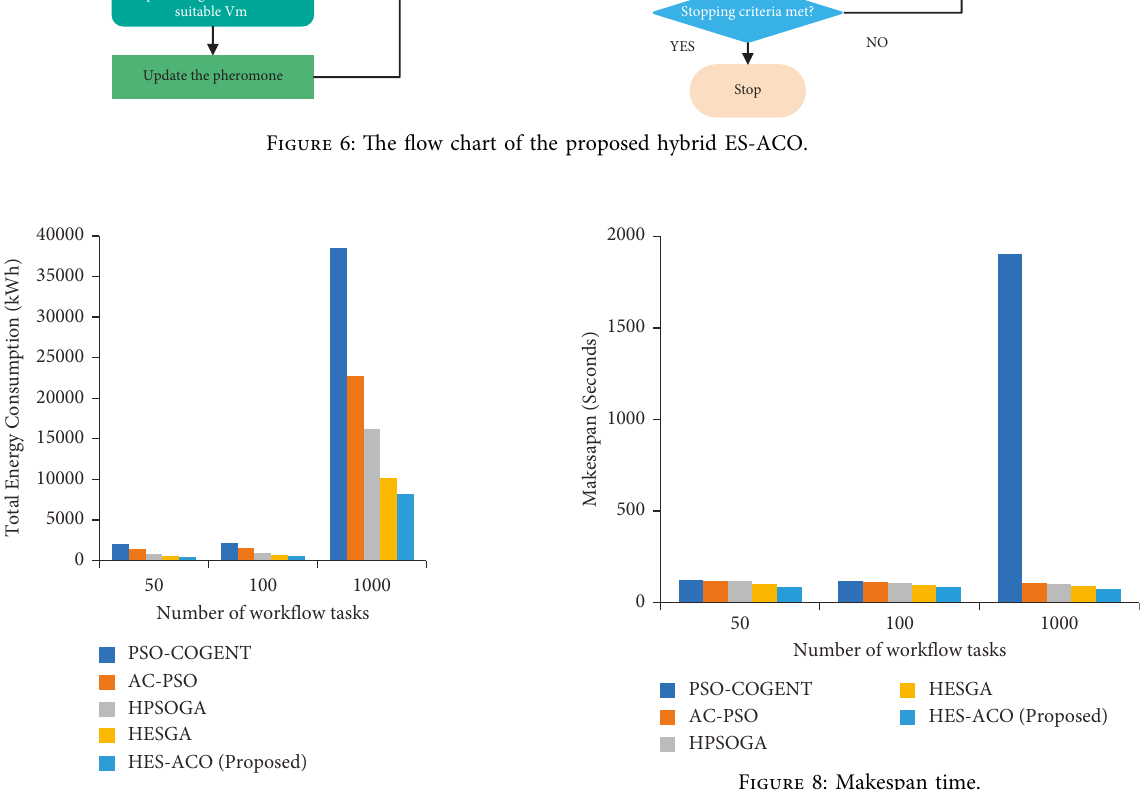
Figure 7: Energy consumption.